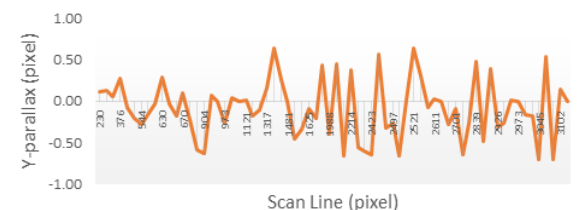
Figure 7. Y-parallax of corresponding points on the generated epipolar images